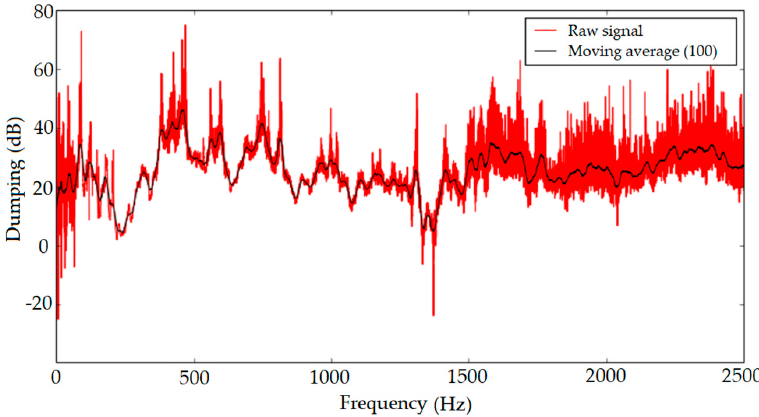
Figure 8. Resistance to external interferences.